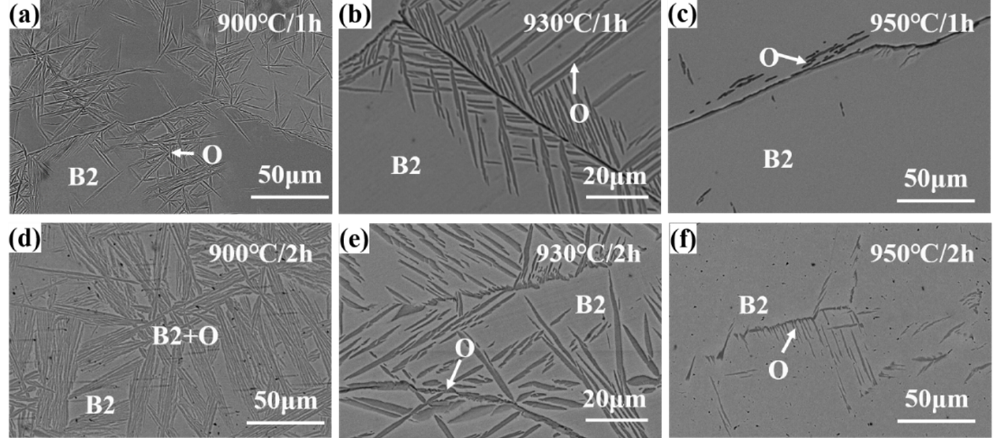
Figure 7. The BSE images of the heat-treated Ti-22Al-25Nb alloy at ( a ) 900 °C/1 h, ( b ) 930 °C/1 h, ( c ) 950 °C/1 h, ( d ) 900 °C/2 h, ( e ) 930 °C/2 h, ( f ) 950 °C/2 h.